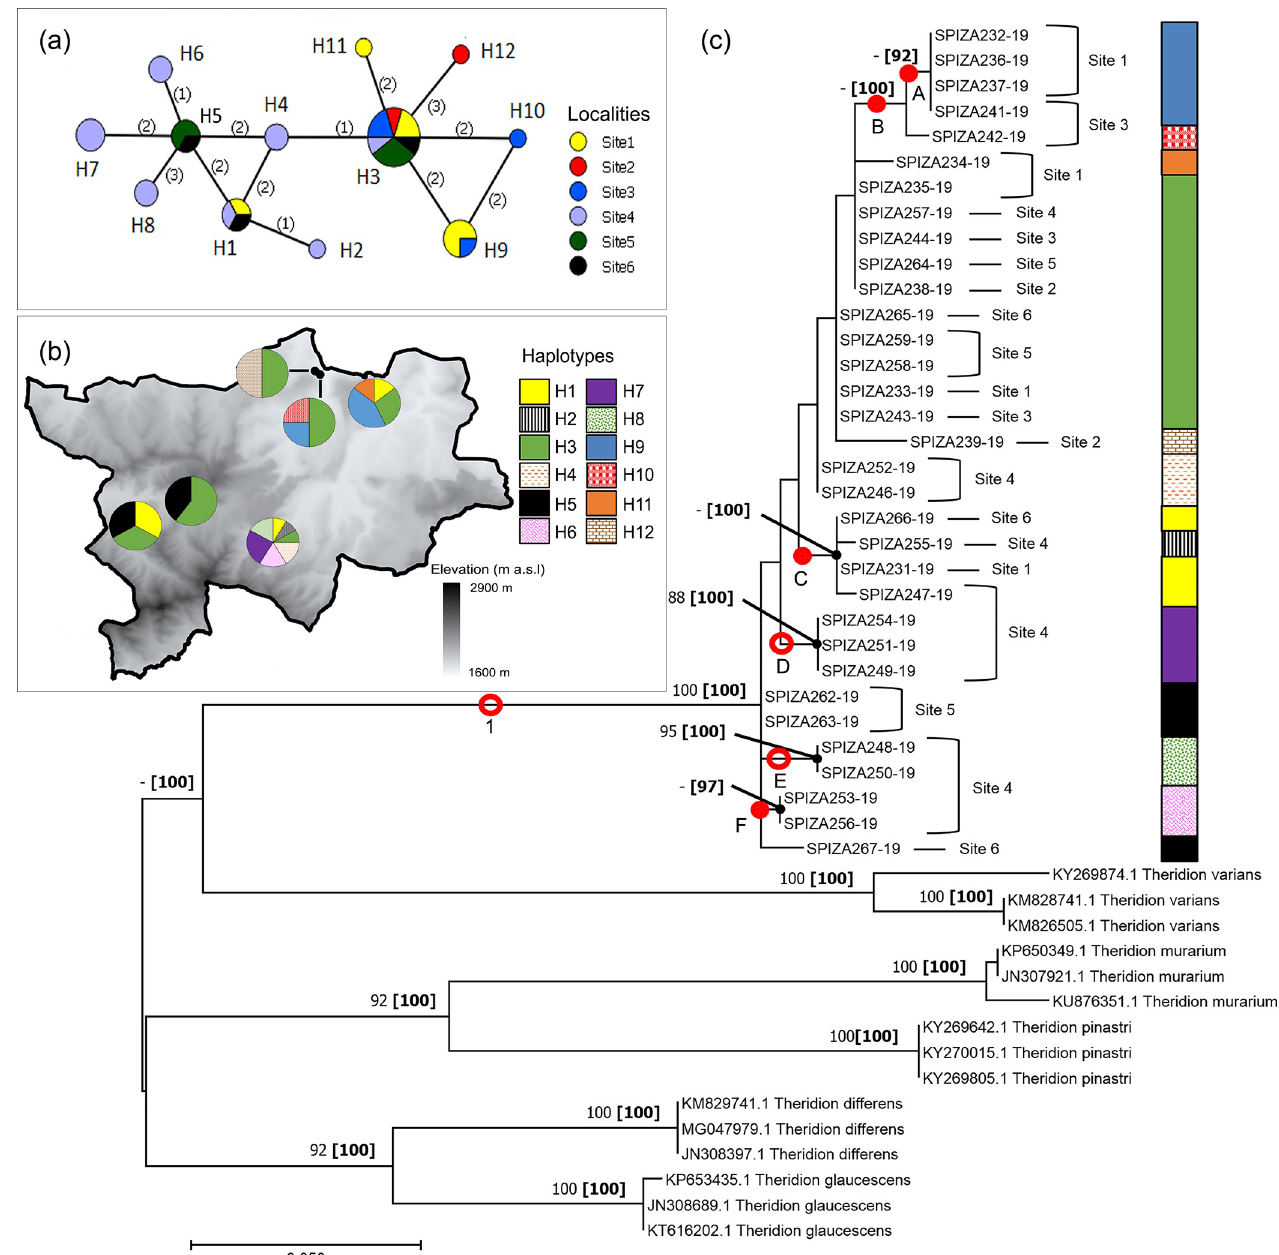
Fig 6. Haplotype networks and phylogram of the Theridion sp. populations of the Golden Gate Highlands National Park, based on a portion of mt DNA COI gene. (a) Minimum Spanning Network (MSN) connecting sampled sequences through putative mutational steps according to geographical locality of populations. Circles represent defined haplotypes, while circle diameters are proportional to frequency. Numbers in parentheses correspond to mutational steps. (b) Distribution of defined haplotypes within sampled localities. (c) Phylogenetic tree based on Maximum Likelihood (ML) showing relationship of the Theridion sp. with five sister species. Red circles and dots represent well-supported and putative clades/groups, respectively. Localities and haplotypes of individuals corresponding to the MSN are also indicated. Phylogram is rooted at midpoint. Numbers at nodes correspond to bootstrap percentages alongside posterior probability percentages in parentheses. Only values > 80% were